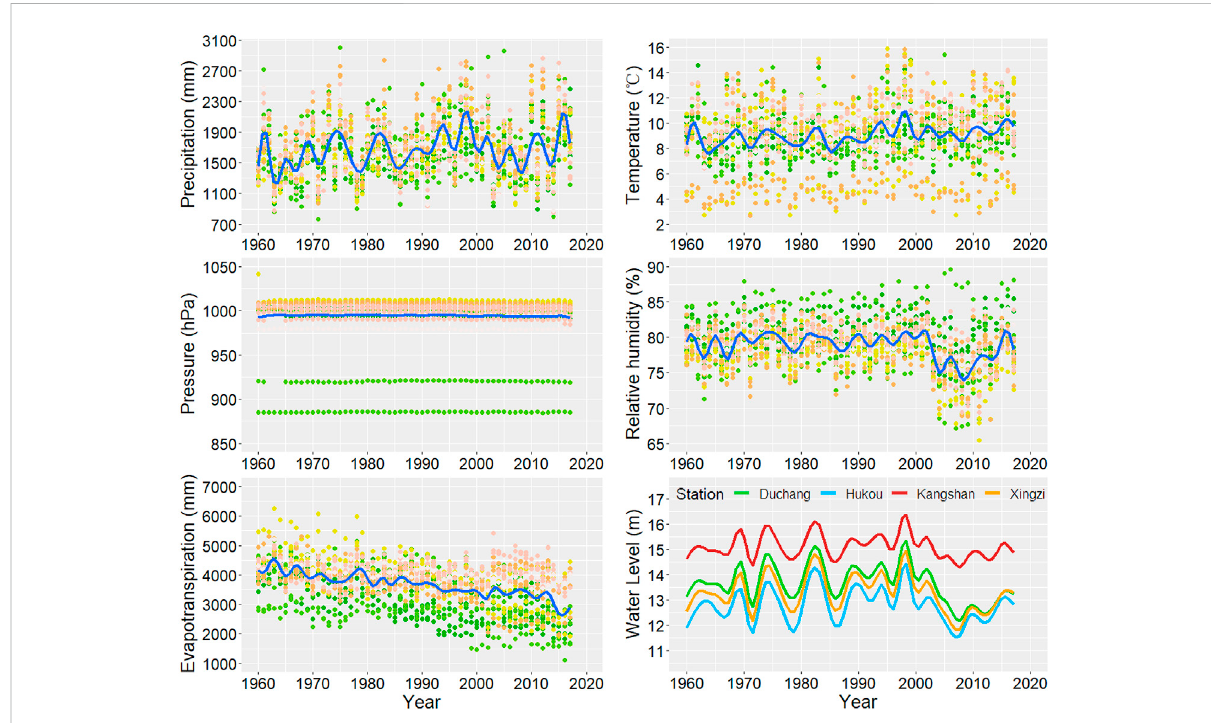
FIGURE 3 Time series ofhydrometeorological variables derived from gauging stations inthePoyang Lake basin during 1960 – 2017. The points indifferent colors represent the measured value from different meteorological stations. The blue lines in each meteorological variable represent the time series of multi-site averages. Color lines in the right-bottom panel are the measured value derived from hydrological